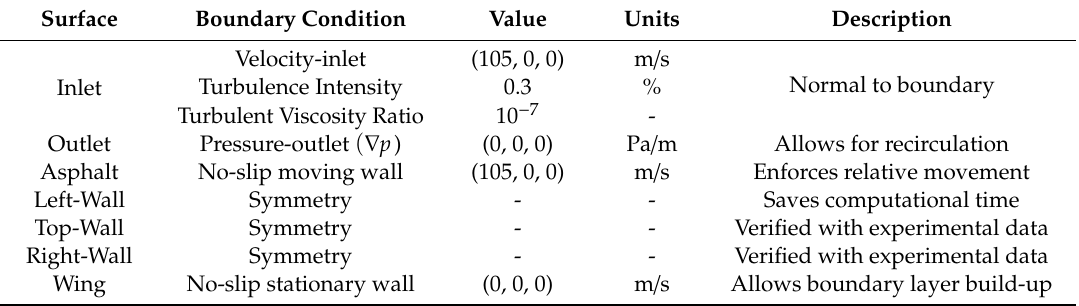
Table 5. Summary of boundary conditions employed in the simulations.